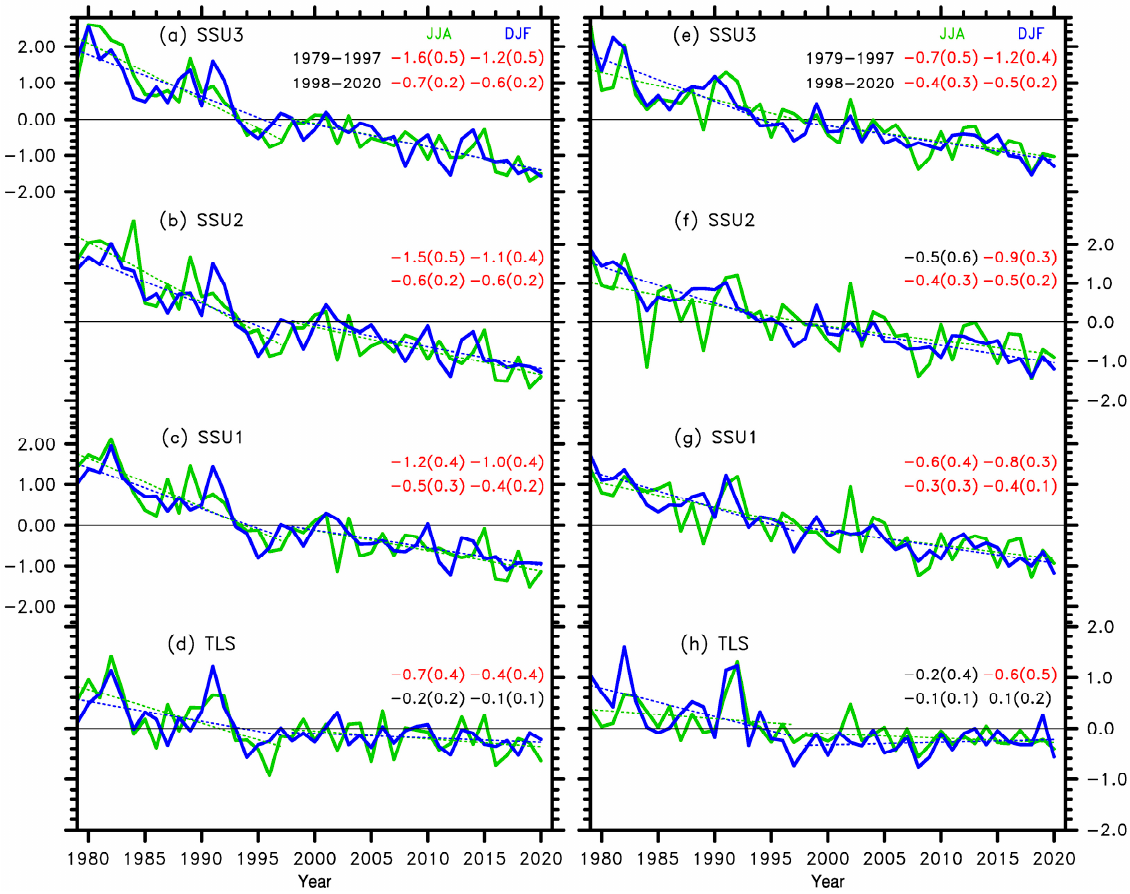
Figure 3. Time series of stratospheric temperature anomalies over 1979–2020 in the ( a – d ) NH and ( e – h ) SH in SSU channel ( a , e ) 3 (~40–50 km), ( b , f ) 2 (~35–45 km), ( c , g ) 3 (~25–35 km), and ( d , h ) TLS. The green and blue lines represent stratospheric temperature averaged in JJA and DJF, respectively. The units are K. The dotted lines indicate the linear regression over 1979–1997 and 1998–2020. The linear trends in JJA and DJF over 1979–1997 and 1998–2020 are marked in the upper right of each panel. Red and black values are statistically significant and insignificant, respectively, at the 95% confidence level using Student’s t ‐ test, with two σ uncertainties in brackets. The units for the trends are K/decade. Figure 4 shows the spatial distributions of linear trends in stratospheric temperature over 1979–1997 and 1998–2020 in JJA and DJF in SSU channel 1, 2, 3, and TLS. In SSU channel 3, significant stratospheric cooling occurs in the tropics and summer hemisphere, which can reach − 2.9 and − 3.2 K/decade over 1979–1997 in JJA and DJF, respectively, and − 1.2 and − 2.7 K/decade over 1998–2020 in JJA and DJF, respectively (Figure 4a–d). In SSU channel 2 and 1, the maximum cooling is located on the equator and decreases with in ‐ creasing latitude, except for the high latitudes in the winter hemisphere (Figure 4e–l). In the lower stratosphere, significant cooling mainly occurs in the middle latitudes of the summer hemisphere over 1979–1997, with maximum values of − 1.1 and − 1.3 K/decade in JJA and DJF, respectively (Figure 4m,n). The long ‐ term trends during 1998–2020 are weak and generally insignificant in the lower stratosphere (Figure 4o,p). Compared to the weak cooling in the NH in boreal summer during 1998–2020, the SH shows a little warming in austral summer, which is consistent with the interhemispheric asymmetry of ozone vari ‐ ations.